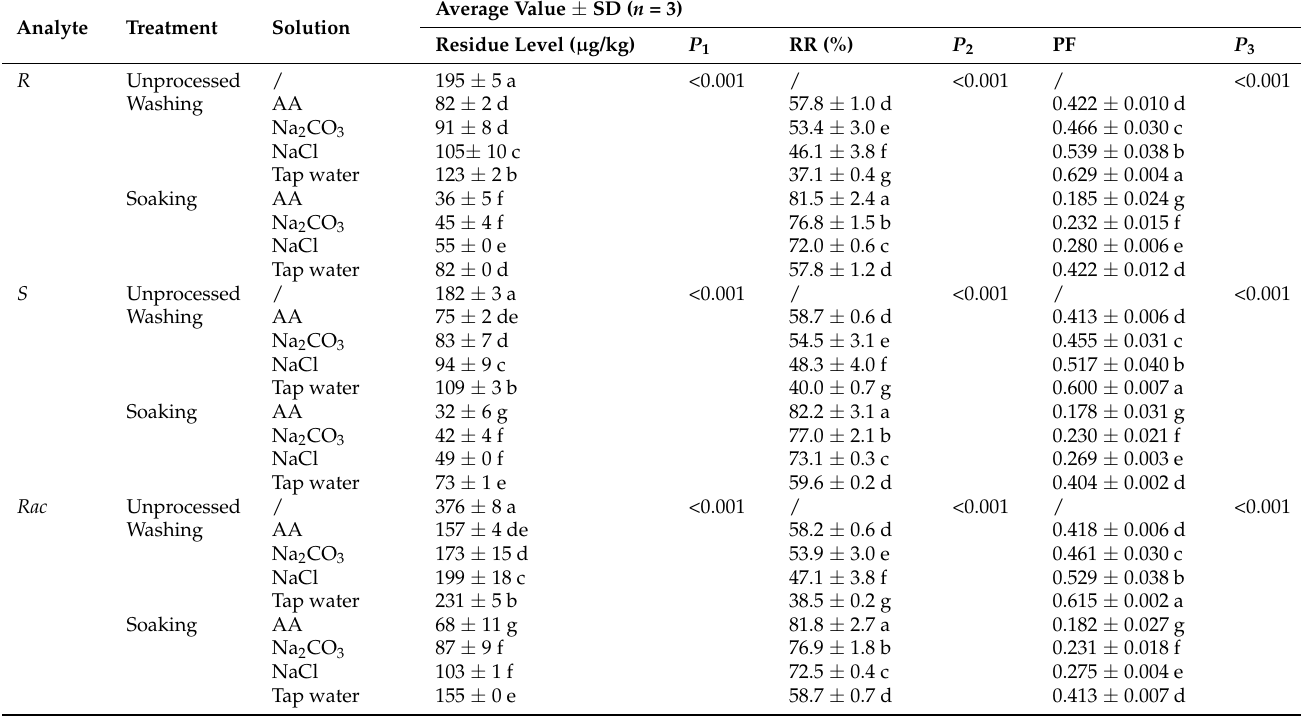
Table 1. Residue level, removal rate (RR) and processing factor (PF) values of mandipropamid in unprocessed, washing, and soaking tomato